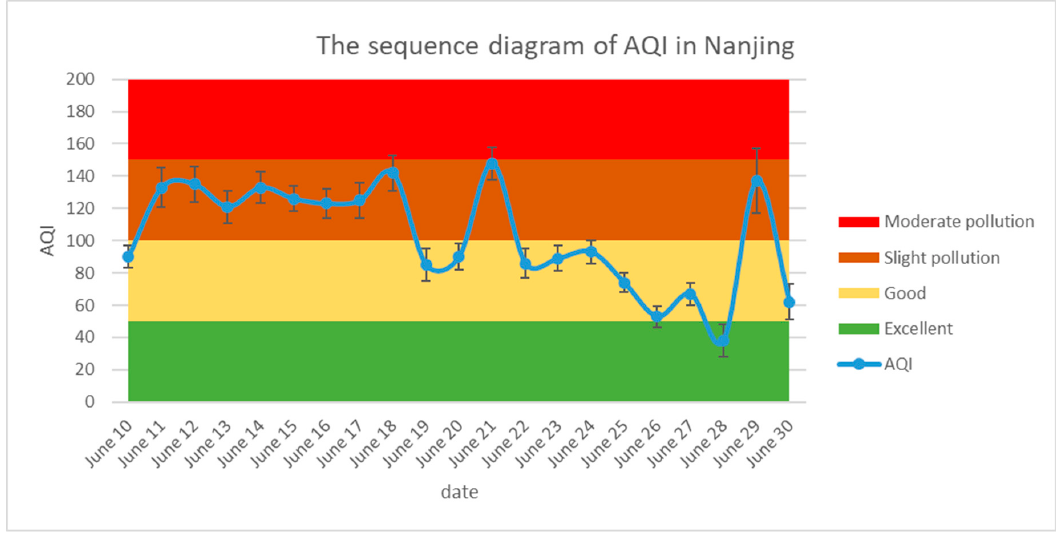
Figure 3. Nanjing air quality index (AQI) time evolution during the haze event.